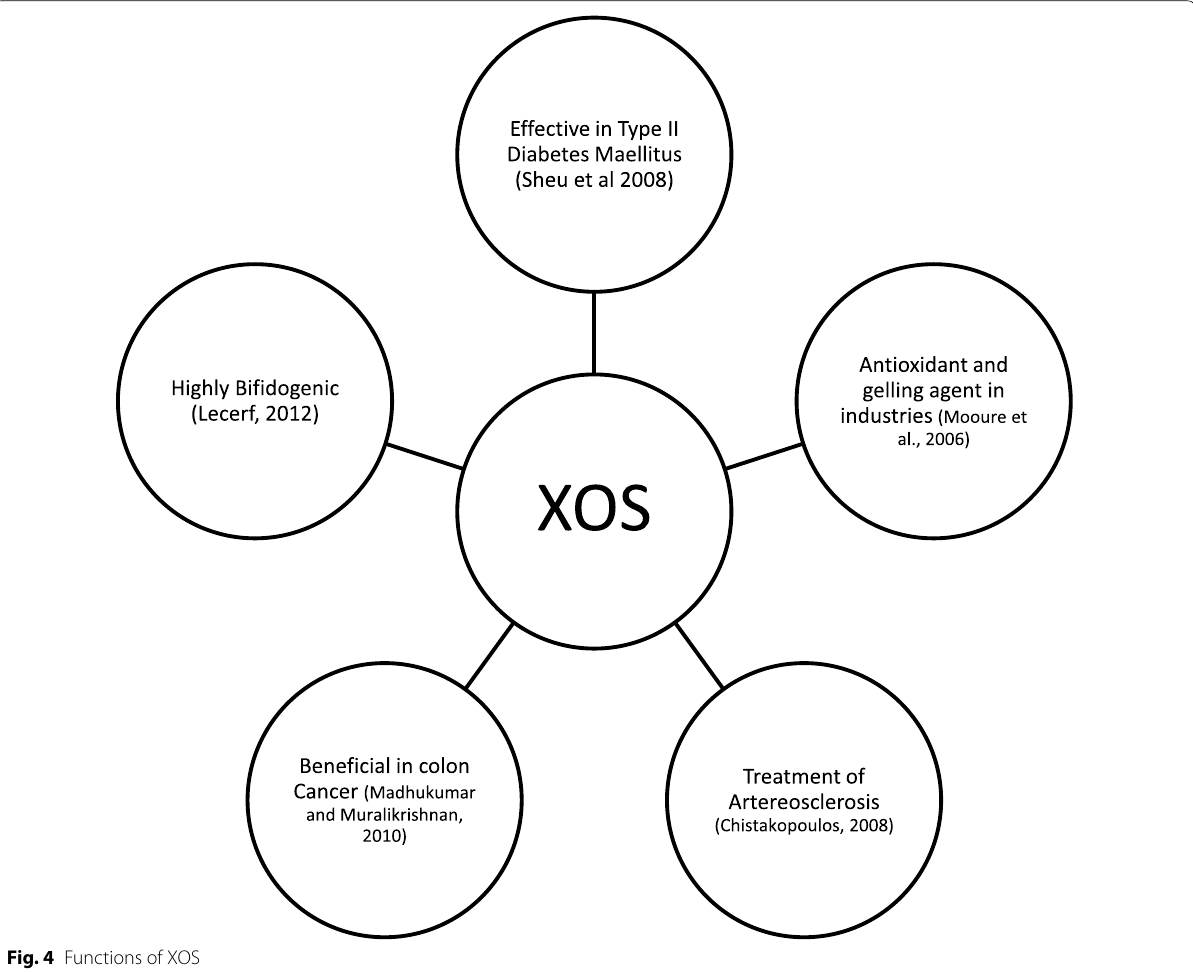
Fig. 4 Functions of